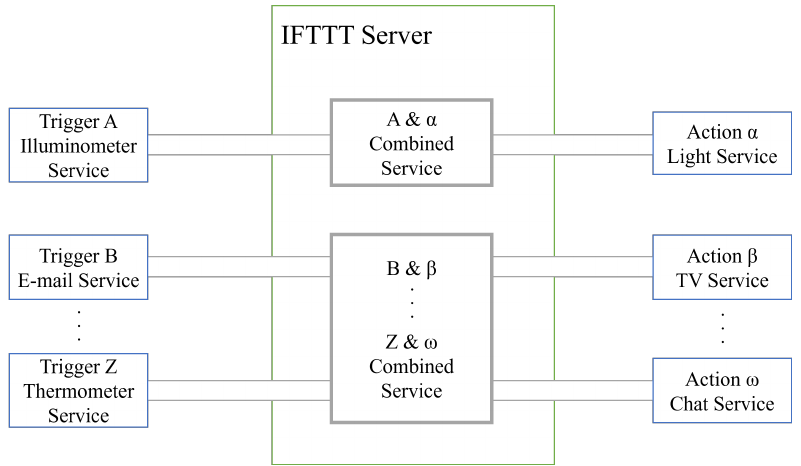
Figure 5. Service connections with